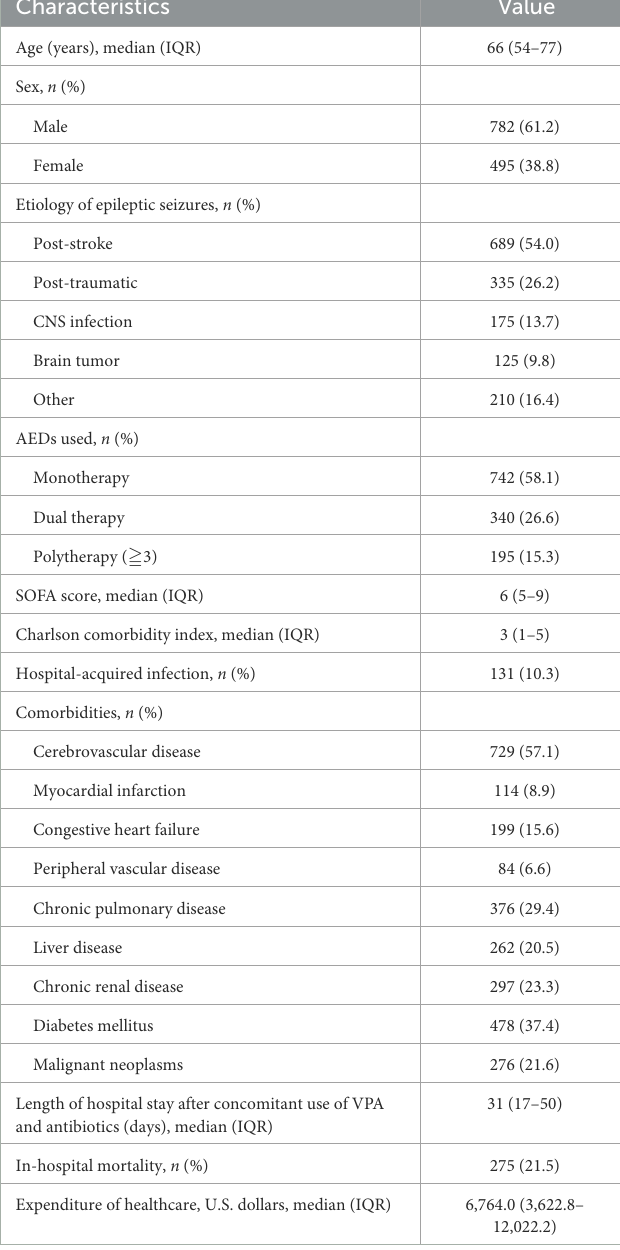
TABLE 1 Characteristics of VPA-treated patients with concomitant antibiotics use ( N = 1,277).